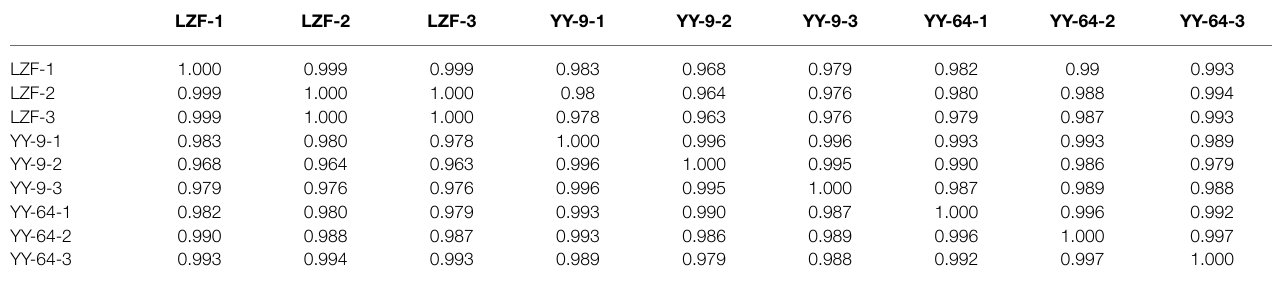
TABLE 1 | Similarity analysis of three kinds of LZF.